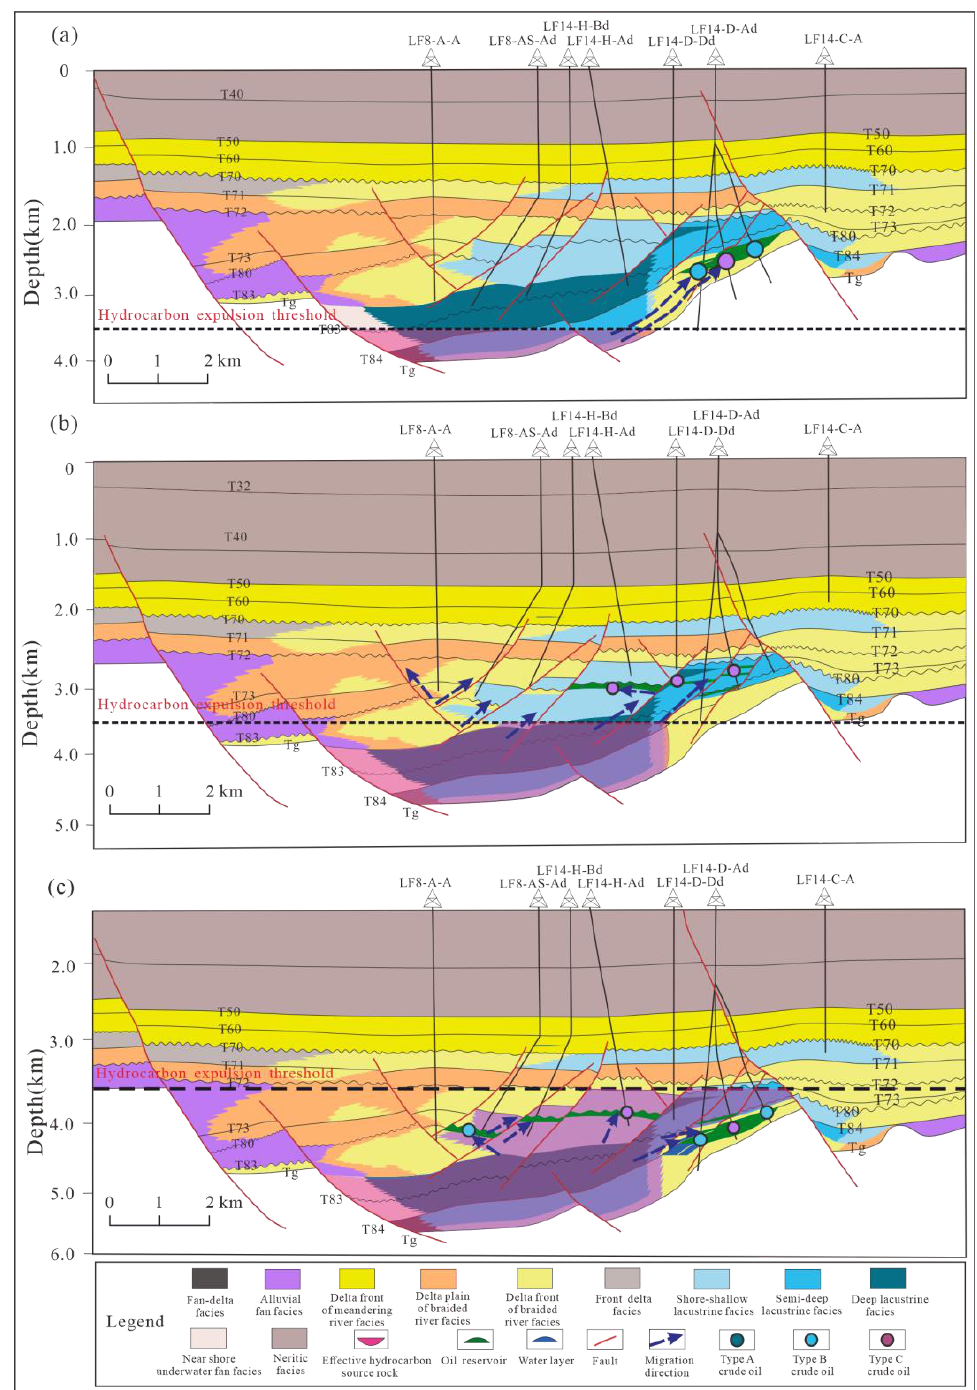
Figure 15. Characteristics of oil and gas migration and accumulation in the southern Lufeng region (the section position is shown in Figure 1c A- A’) : ( a ) first hydrocarbon accumulation periods; ( b ) second hydrocarbon accumulation period; ( c ) third hydrocarbon accumulation period.